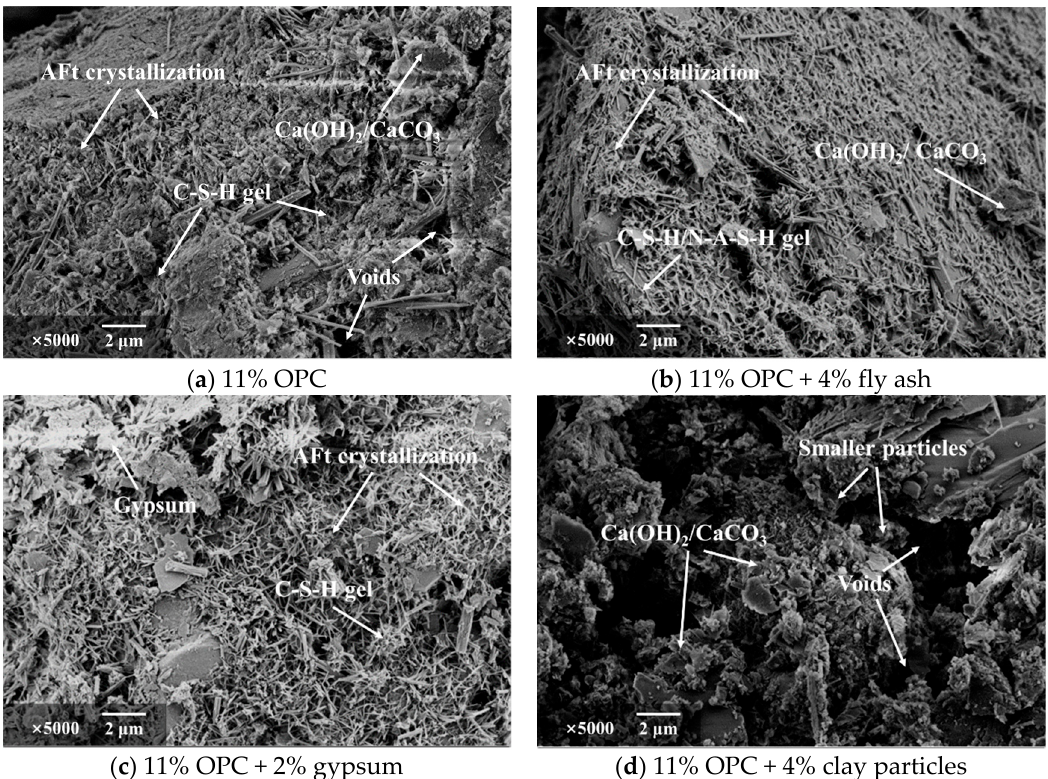
Figure 11. FESEM micrographs of specimens with and without additives after curing for 28 days (5000 times).